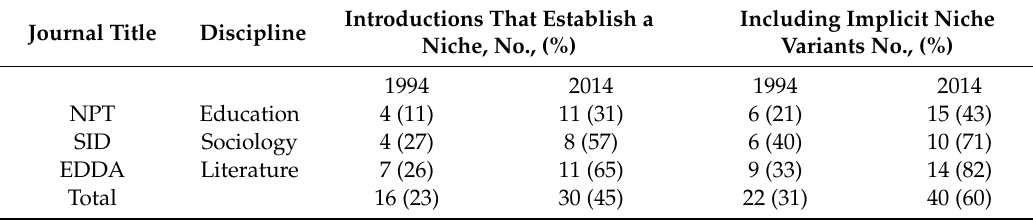
Table 3. Number of introductions that establish a niche, including implicit niche